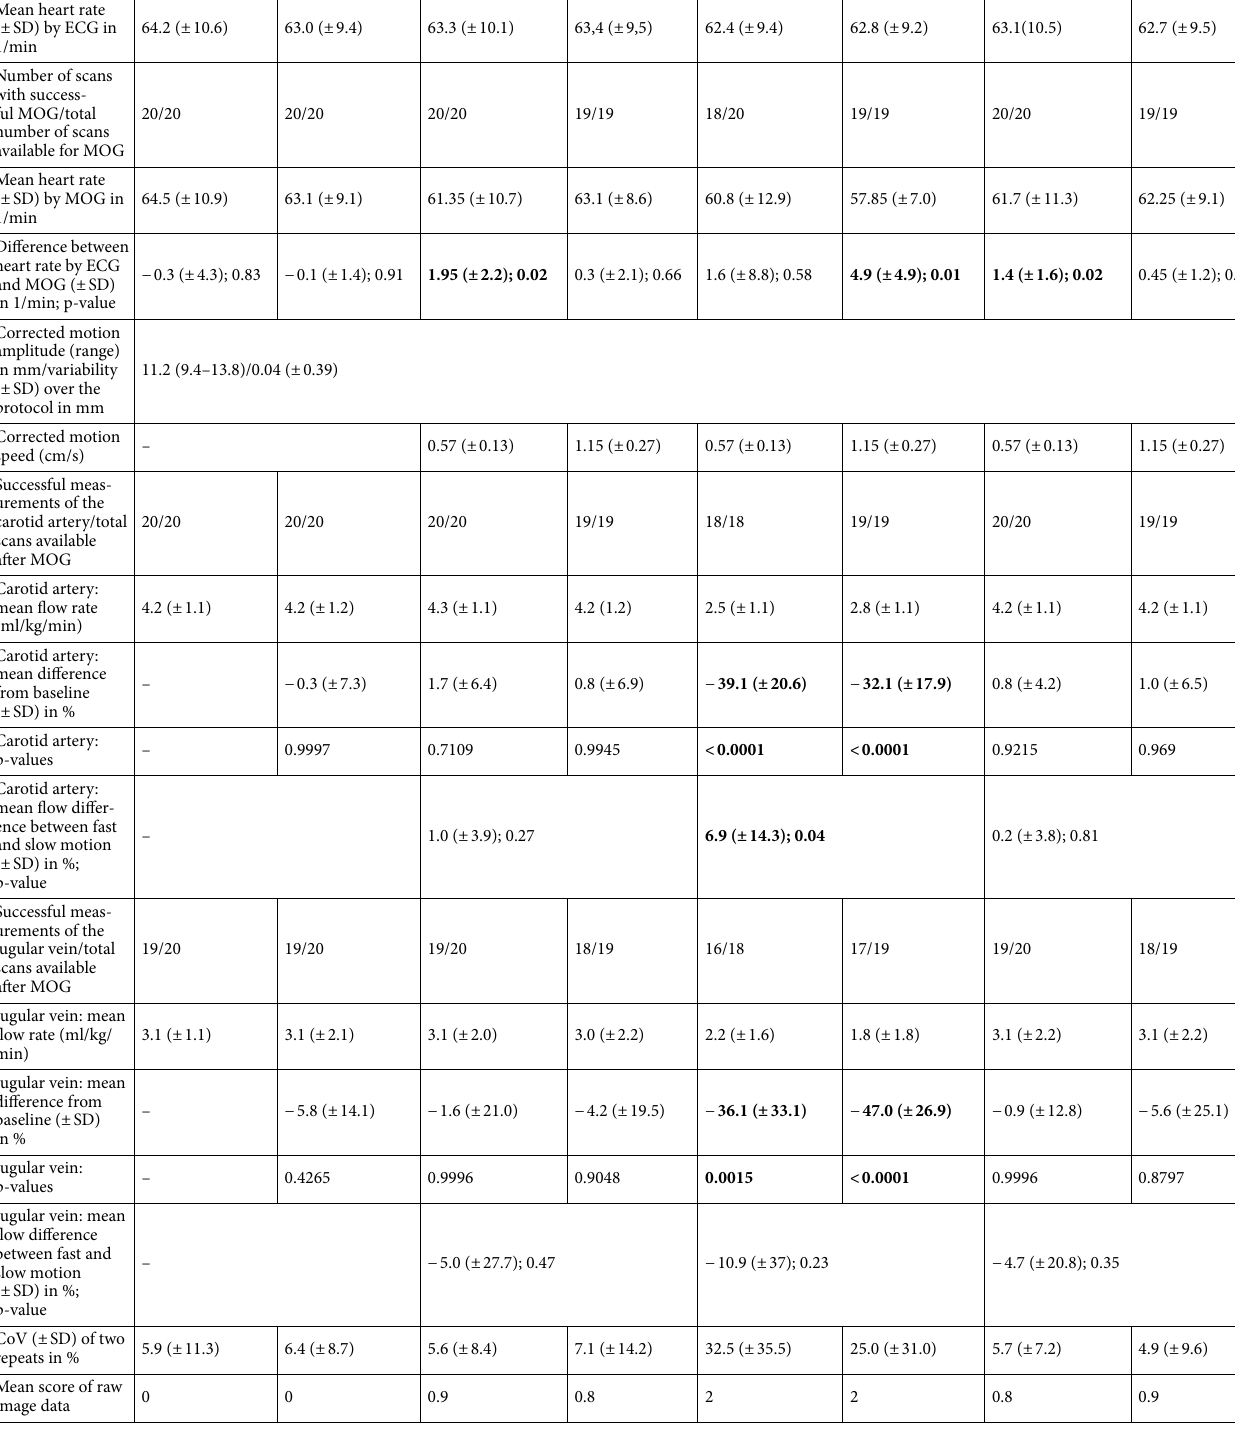
Table 1. Overview on measurements corrupted with motion on different timepoints of the scan (sections). CoV coefficient of variation, SD standard deviation. Significant values are in